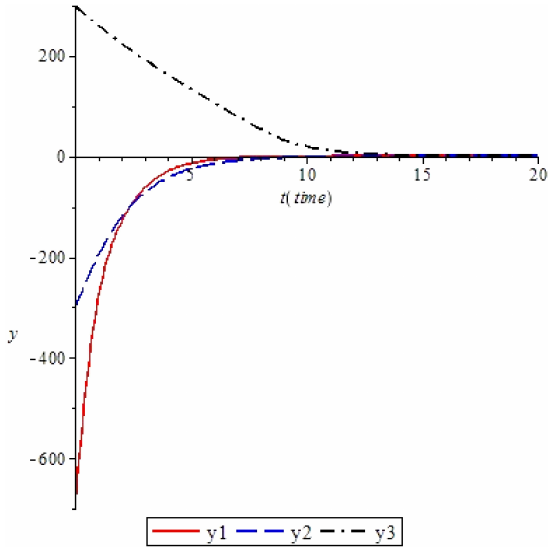
Fig. 5. Graphs of optimal trajectories y ð t Þ